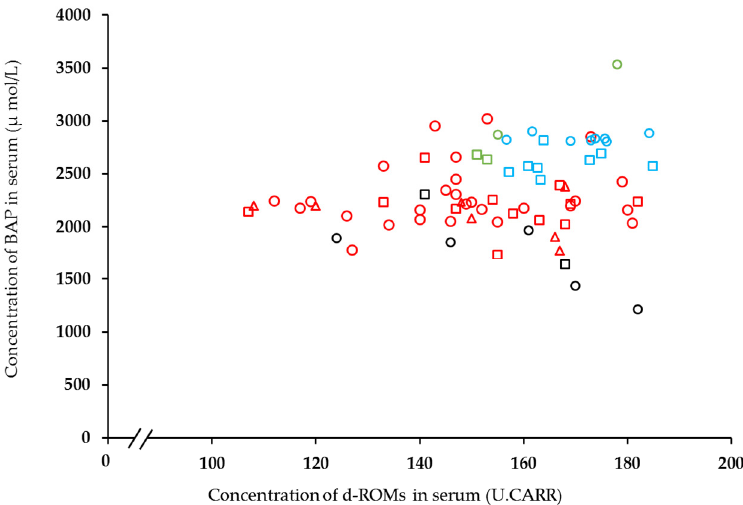
Figure 2. Comparison between d-ROM and BAP concentrations in serum of horses in an equestrian club in Shizuoka Prefecture and that of race and endurance horses. Red and black symbols: horses in an equestrian club in Shizuoka Prefecture in our study (circle: thoroughbreds; square: ponies; triangle: full-sized horses other than thoroughbreds). Black symbols indicate horses with decreased physical activity (mean value of these 7 animals was indicated in [17]). Blue symbols: endurance horses [19] (square: before a race; circle: after a race). Green symbols: racehorses (thoroughbreds) (square: before simulated race; circle: after simulated race)[20].